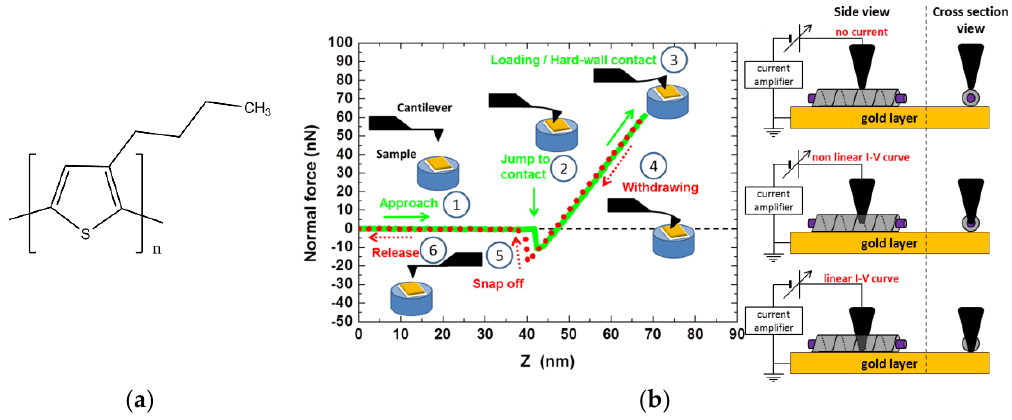
Figure 10. ( a ) Chemical structure of P3BT. ( b ) Right: the tip of the C-AFM is gradually allowed to penetrate into the selected fibril until it reaches the gold layer. The current and the force are simultaneously measured to determine the conductivity and the penetration depth, respectively (for details see reference [26]). Copyright 2018 John Wiley & Sons.